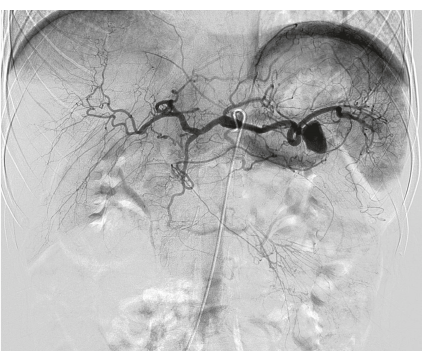
Figure 1: Celiac axis arteriogram demonstrating a large pseudoa- neurysm from the mid-to-distal splenic artery.